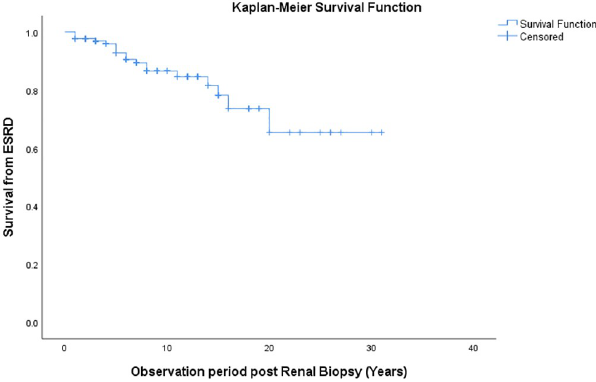
Fig 2. Secondary endpoint analysis, i.e., time to development of ESRD. Kaplan-Meier curve showing the survival from ESRD in the entire cohort.